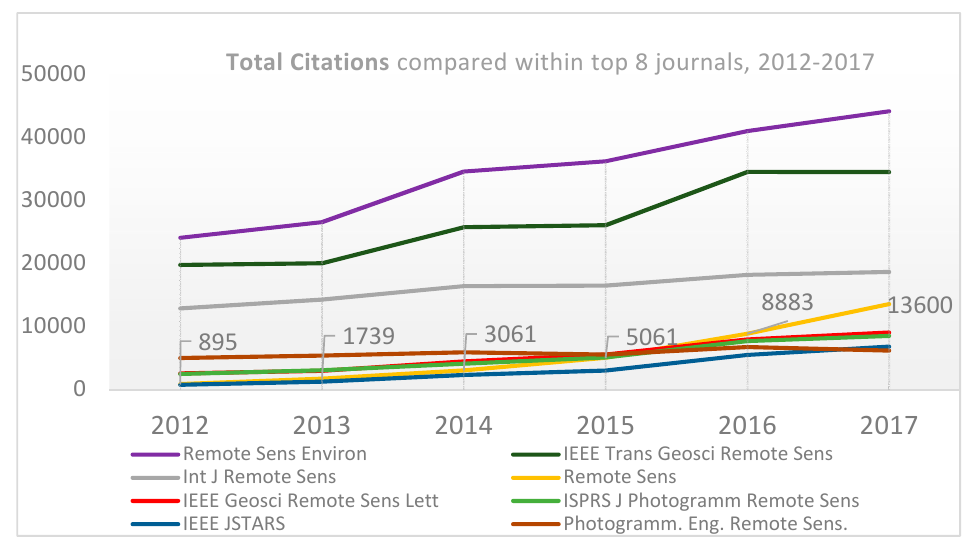
Figure 2. Total number of cites of papers published in RS OAJ during the year 2017 was 13,600.